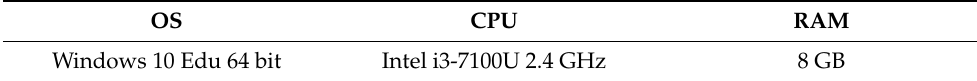
Table 3. Hardware specifications.